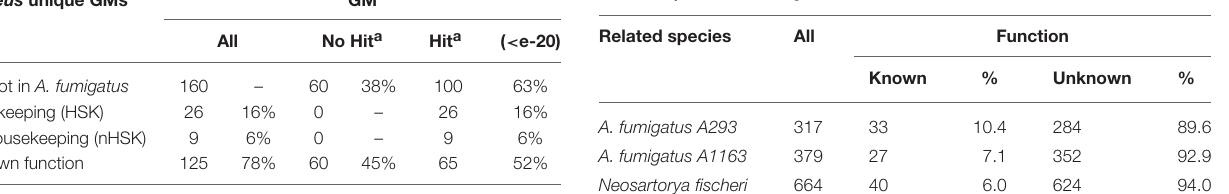
TABLE 5 | GMs in A. fumigatus/fischeri but not in AFUMN.